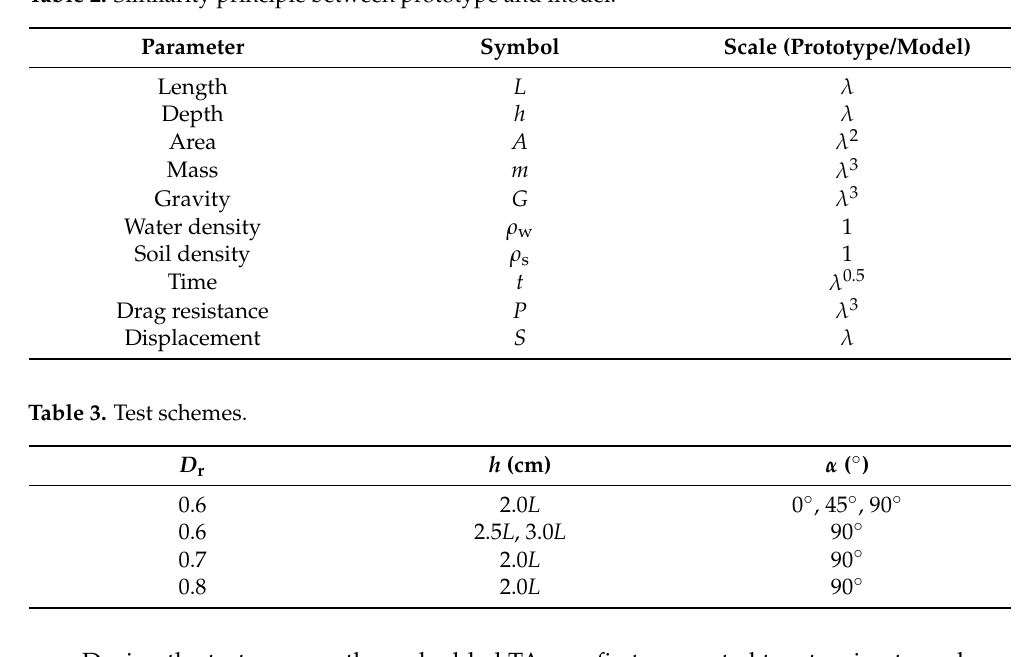
Table 2. Similarity principle between prototype and model.